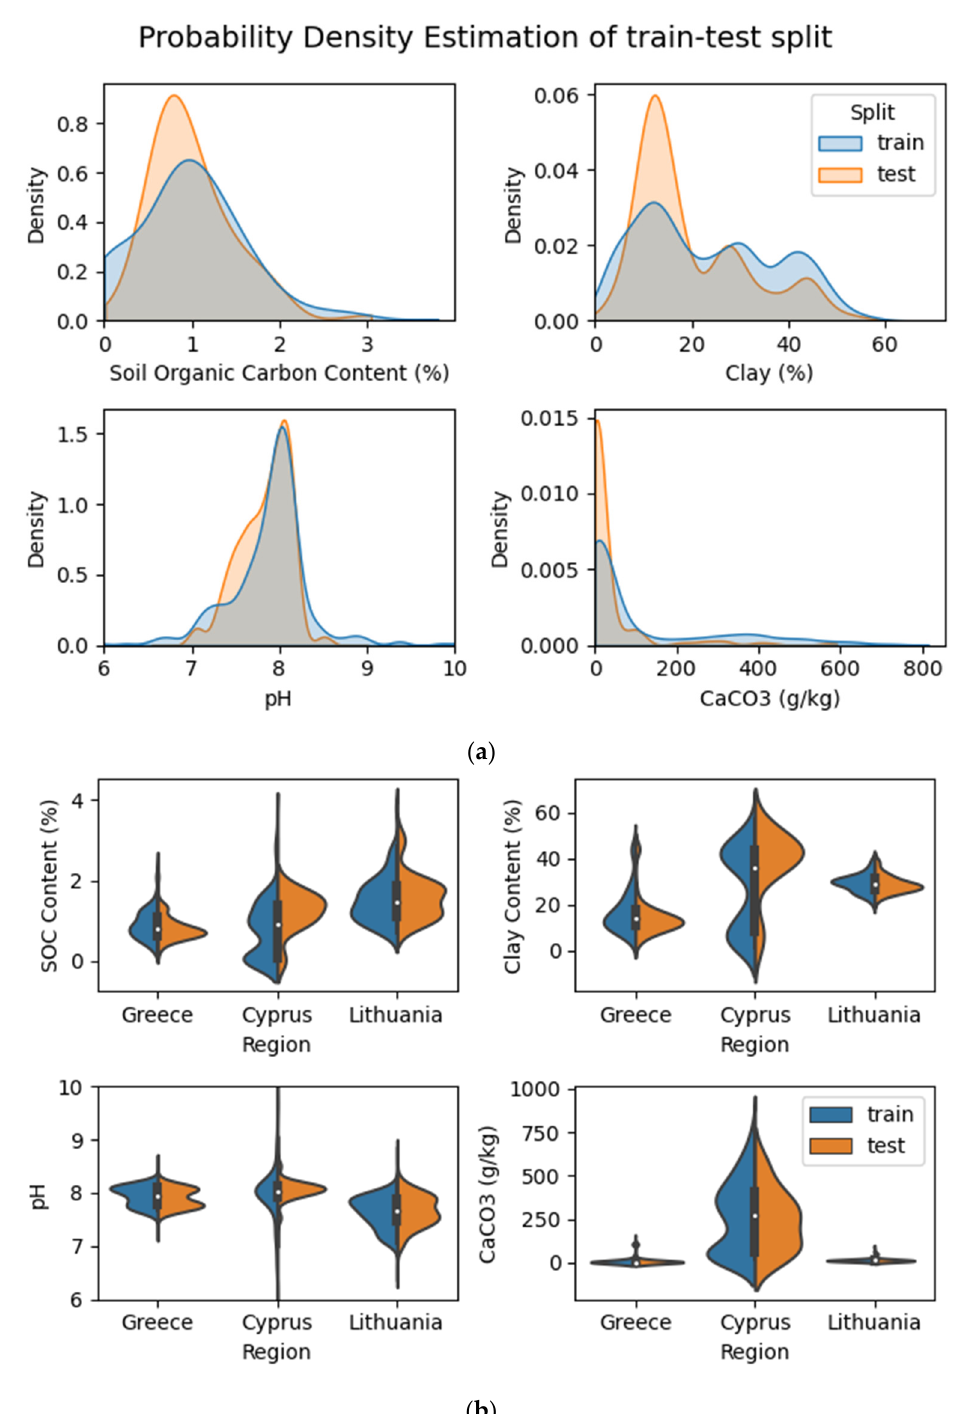
Figure 12. Probability density estimation and the box plot of the train-test split ( a ) for the whole dataset and ( b ) per region for each soil property.